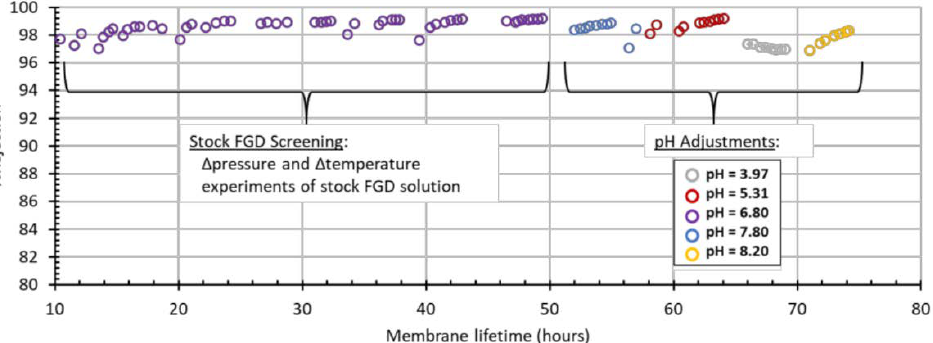
Figure 12. The image shows the %rejection for FGD wastewater of varying pH on Module 2. The membrane showed >96% rejection for all pH values and operating conditions tested. Furthermore, the membrane was able to reach >98% rejection for all pH values under specific conditions.